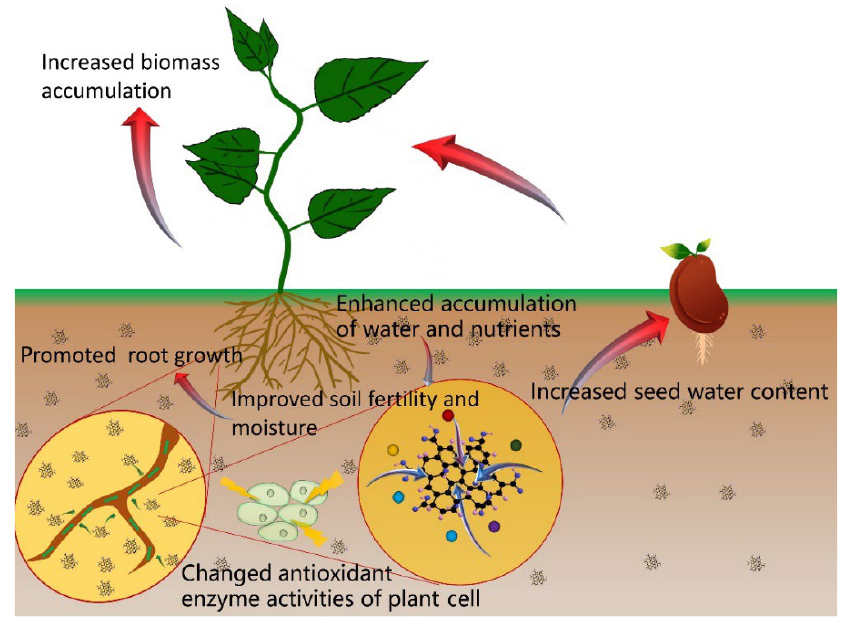
Figure 3. The effects of GO in promoting plant growth.